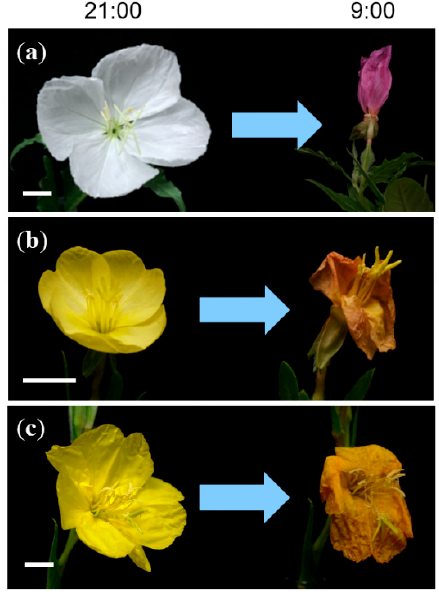
Figure 1. Flower color change in Oenothera petals during senescence. ( a ) Oenothera tetraptera , ( b ) Oenothera laciniata , and ( c ) Oenothera stricta . Scale bars: 1 cm.